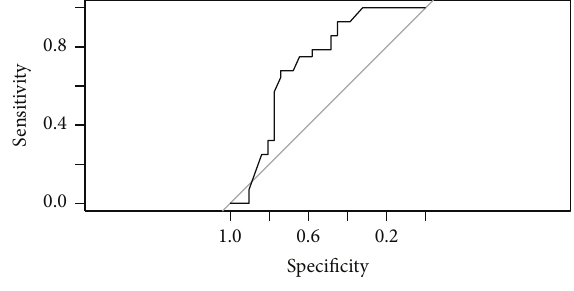
Figure 6: ROC curve for model MOD-C1.